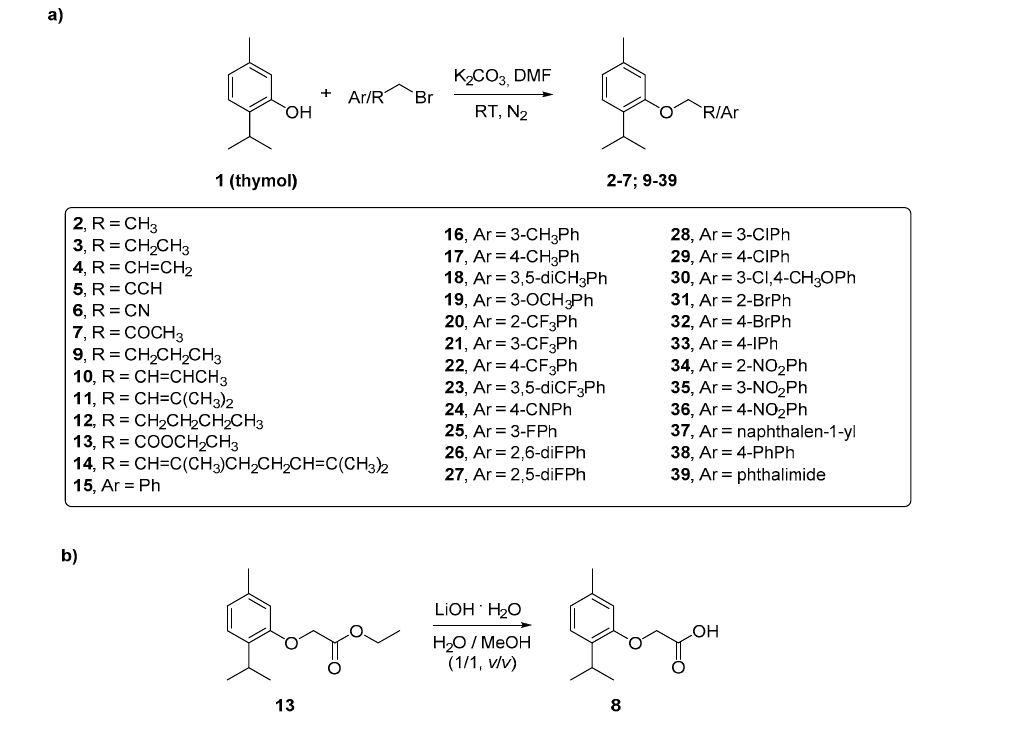
Figure 1. Synthesis of the reported thymol-based compounds 2 – 39 . ( a ) Func- tionalization of the OH moiety of thymol ( 1 ); ( b ) ester hydrolysis to provide moiety of thymol ( 1 ); ( b ) ester hydrolysis to provide compound 8 compound 8 .